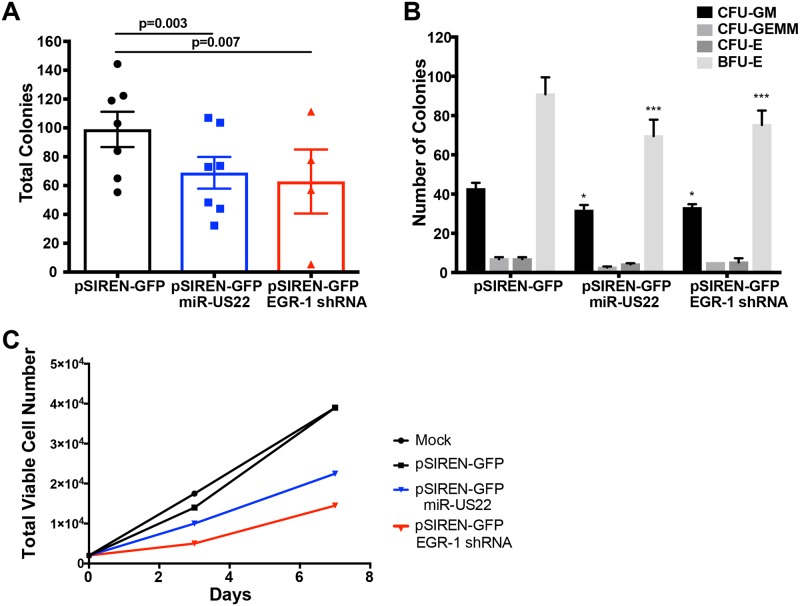
miR-US22 down-regulation of EGR-1 reduces CD34+ HPC proliferation.CD34+ HPCs were transfected with pSIREN-GFP, pSIREN-GFP-miR-US22, or pSIREN-GFP-EGR-1shRNA for 24 hours using Amaxa. Viable CD34+ GFP+ HPCs were isolated by FACS and analyzed for proliferation and differentiation. (A, B) Isolated HPCs were plated on Methocult H4434 (Stem Cell Technologies) at 500 cells/mL in triplicate, and counted at 7 and 14 days. Data shown are the total number of colonies at 7 days (A) for n = 7 (miR-US22) or n = 4 (EGR-1 shRNA) independent experiments, or separate myeloid (CFU-GM, CFU-GEMM) and erythroid (CFU-E and BFU-E) colonies at 14 days (B). Significance was calculated using paired t-test; * p = 0.019, *** p<0.001 compared to pSIREN-GFP control transfected cells. (C) Isolated CD34+ HPCs were plated in SFEMII supplement with hematopoietic cytokines, and counted at day 3 and day 7. Total viable cell number is shown.